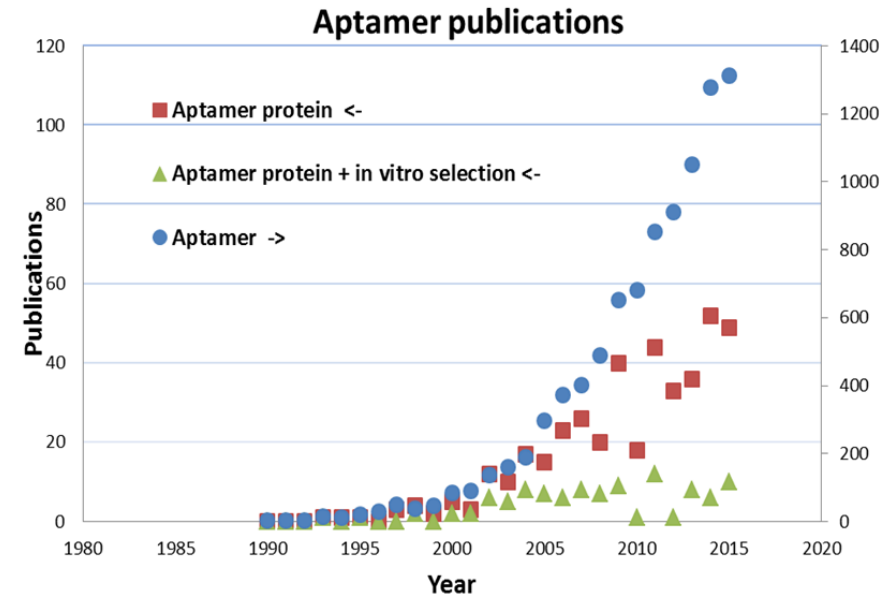
Figure 4. Number of publications subdivided to the search terms ‘aptamer protein’ (squares), ‘Aptamer protein + in vitro selection’ (triangles) and ‘aptamer’ (circles, right axis), until the end of 2015 (generated by means of Scopus [43]).